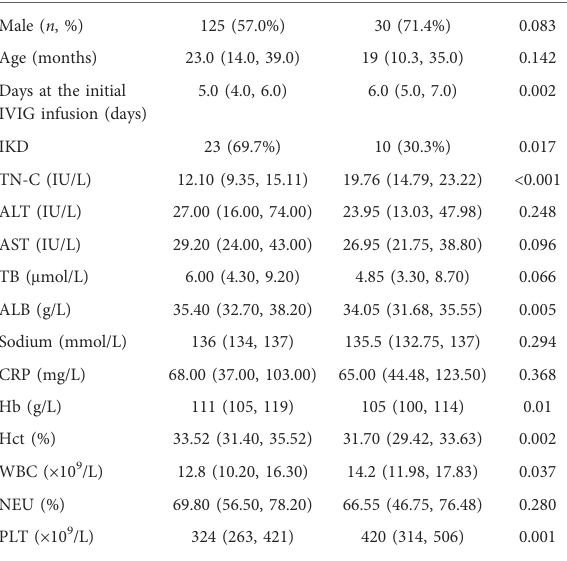
TABLE 3 Comparison of clinical and laboratory characteristics between patients with CALs and NCALs.